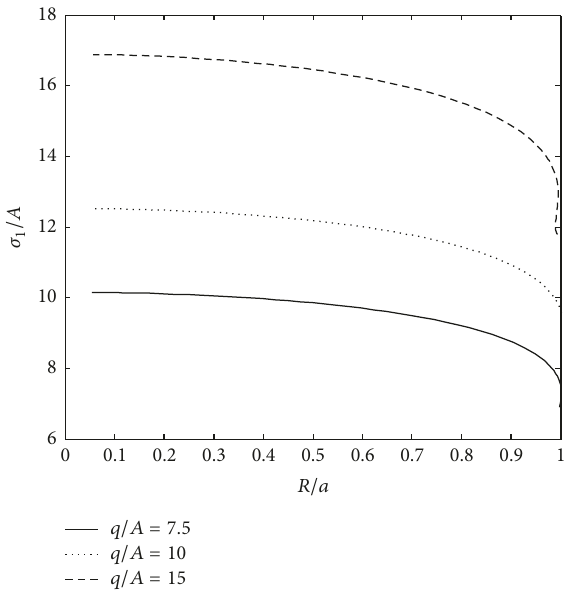
Figure 5: The radical stress distribution curve on membrane ( 𝑛 = 2 ; 𝛼 = 1 ).